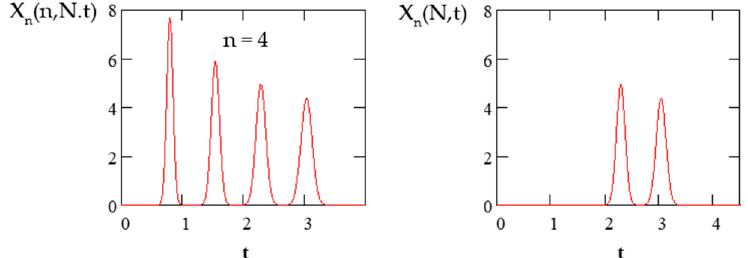
Figure 2. Elution profiles of compound K D = 0.5 calculated using Equations (4) and (8). N = 300, S f = 0.5, t s = 0.1.